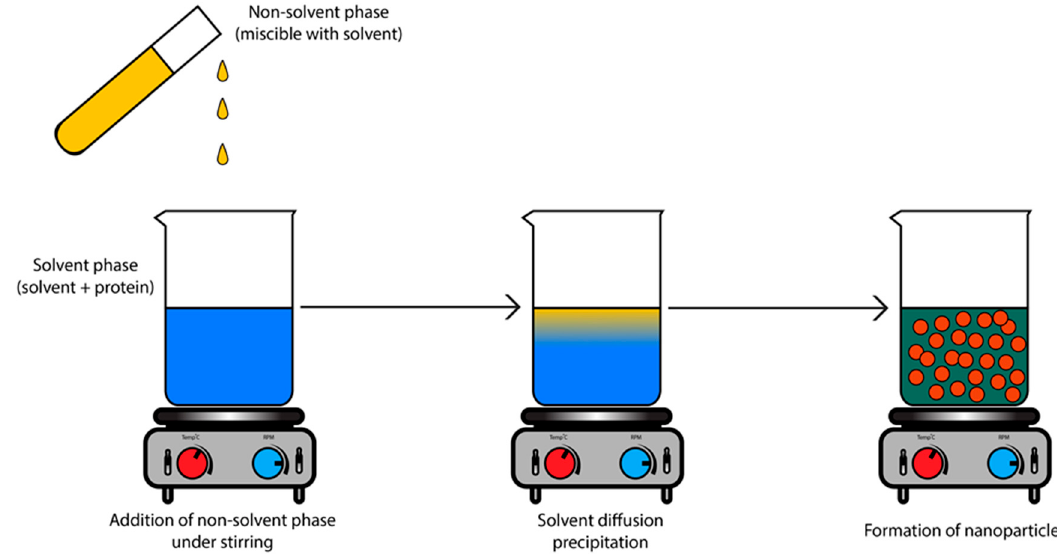
Figure 1. Protein-based nanoparticles prepared by nanoprecipitation method leading to submicron particles. The addition of the non-solvent phase leads to a state of supersaturation which allows the beginning of the nanoprecipitation process and the formation of nanoparticles.